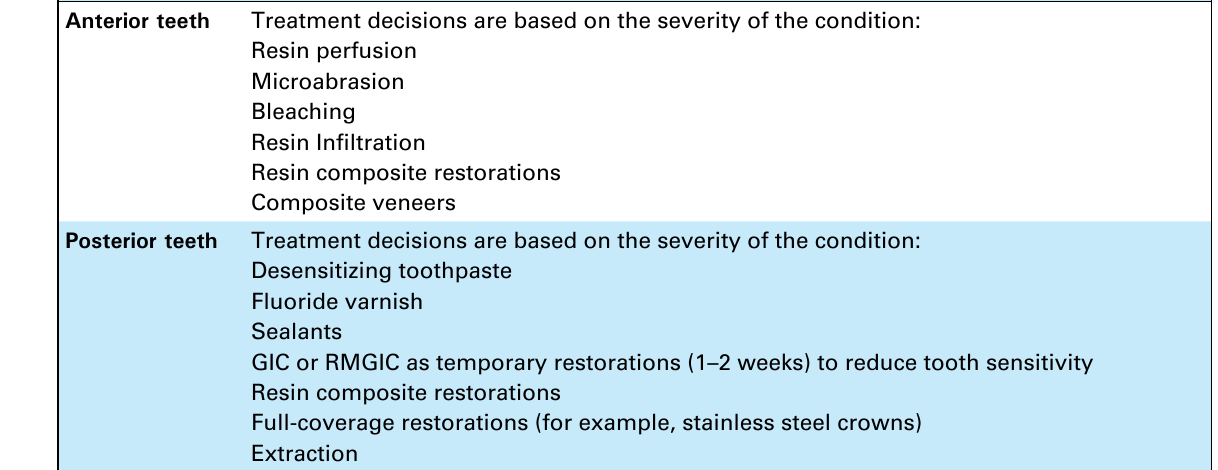
Table 5. Treatment options for molar and incisor hypomineralization. 21,33,40-43,47,49,54-56 Anterior